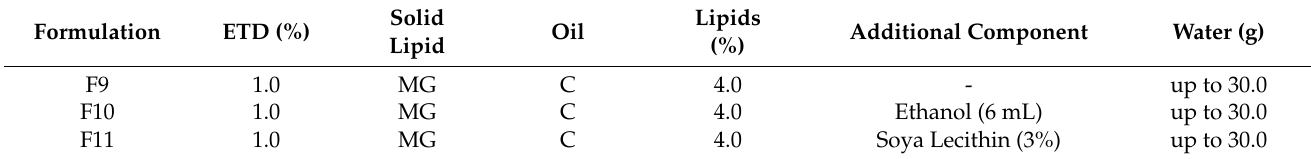
Table 1. Composition of optimized etodolac (ETD)-NLC